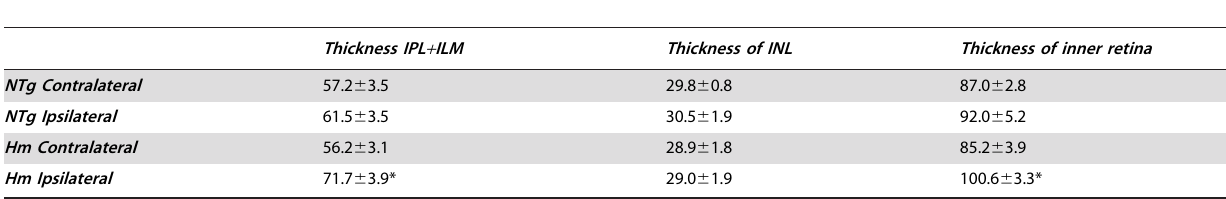
Table 2. Thicknesses of inner nuclear layer (INL), inner plexiform layer (IPL) to inner limiting membrane (ILM) and the whole inner retina ( m